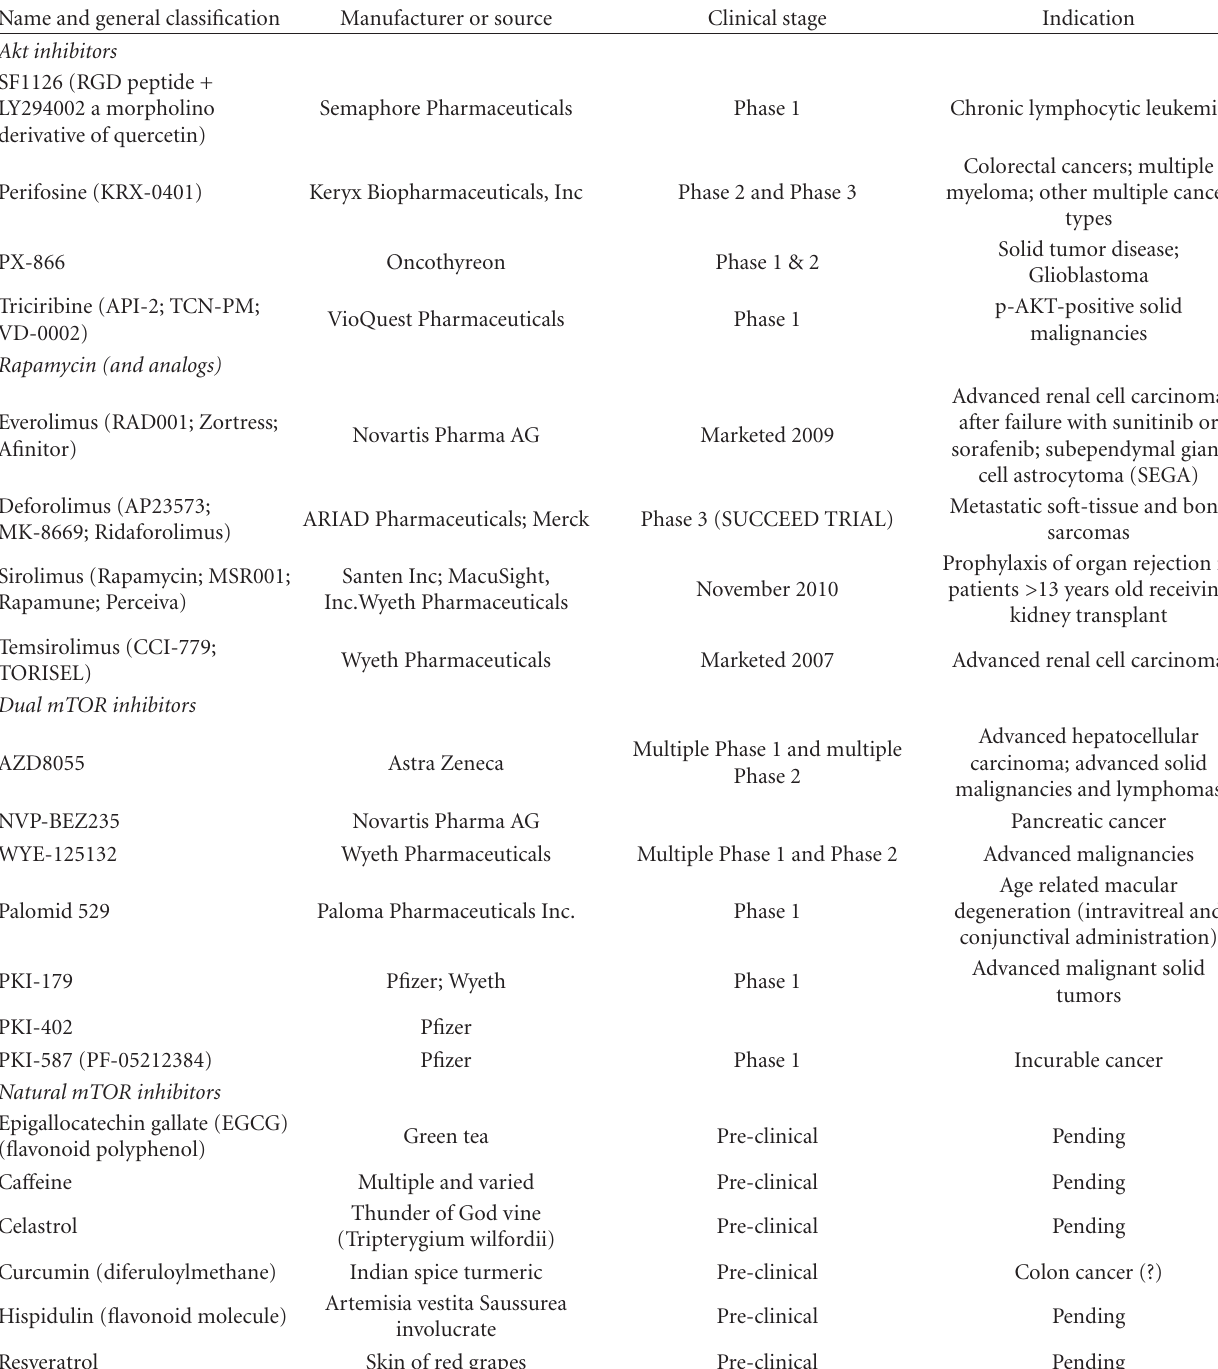
Table 2: Principal PI3K/Akt/mTOR Inhibitors in clinical